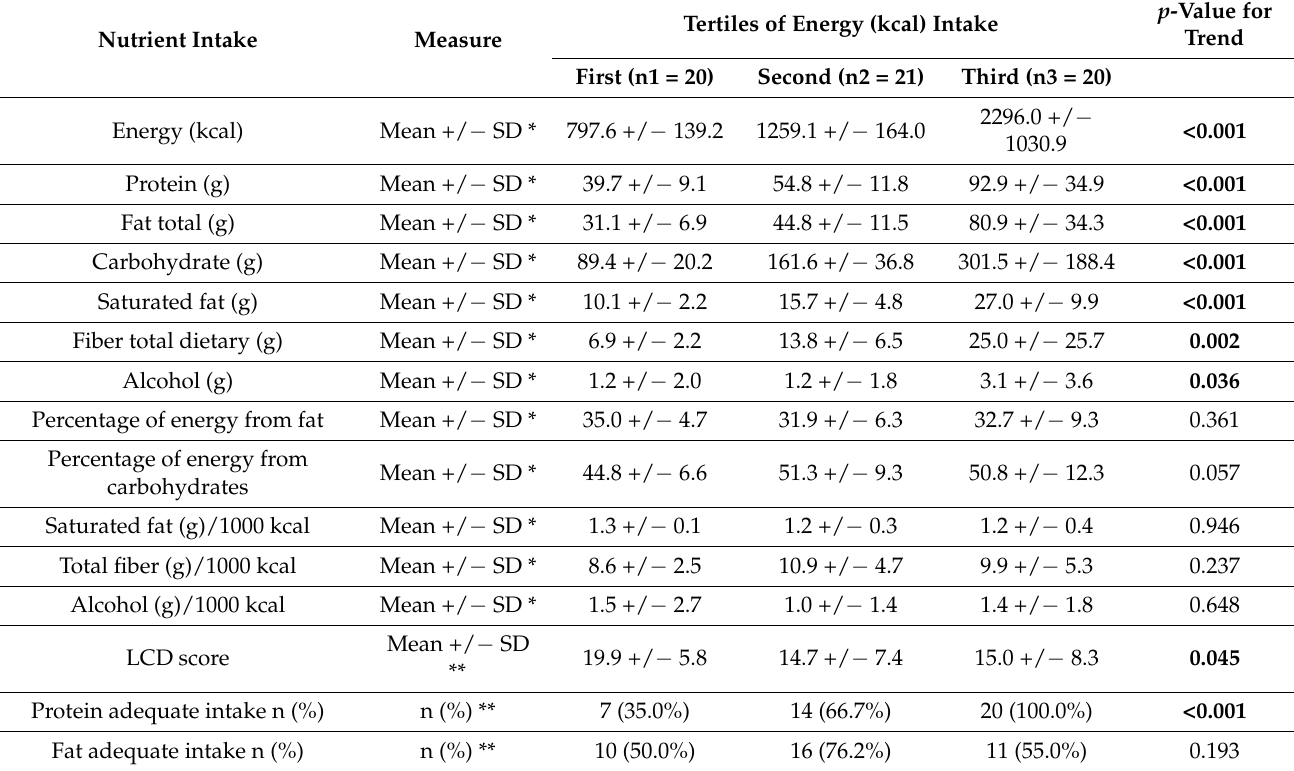
Table 2. Nutrient intake per tertile of energy intake (N =